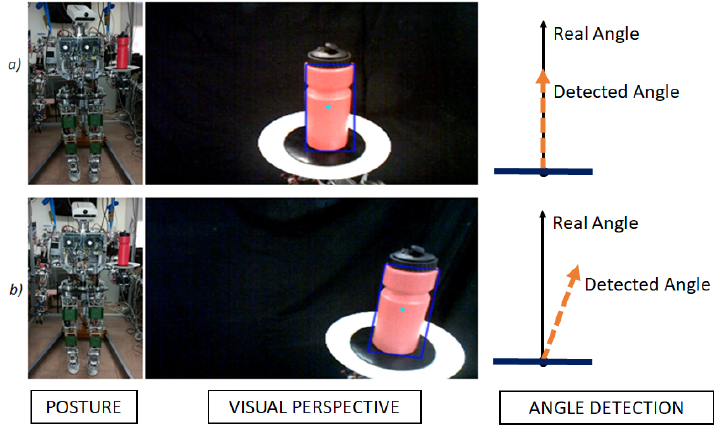
Figure 5. Perspective error, the same tilt angle changing the camera